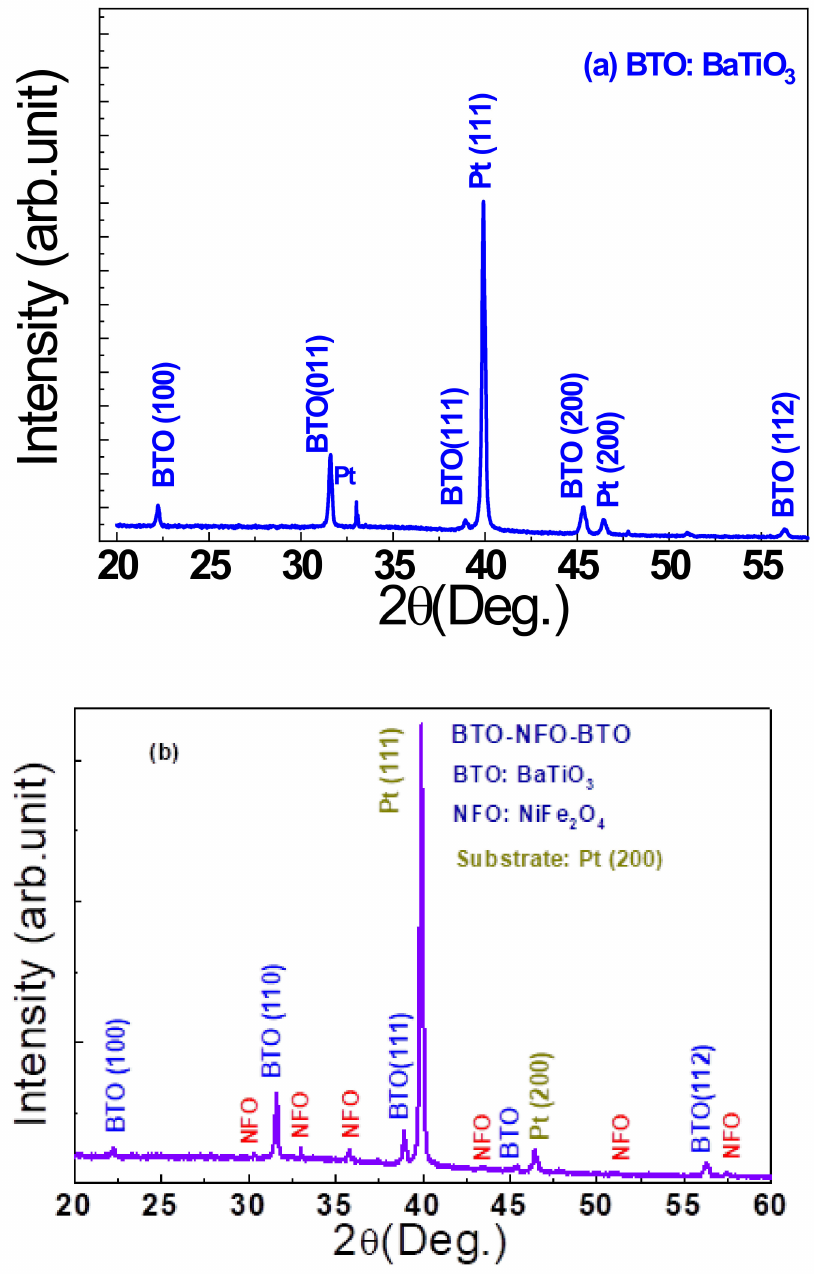
Figure 1. X-ray diffraction pattern of ( a ) BTO and ( b ) (BTO/NFO/BTO) tri-layered thin film on substrate Pt/Ti/SiO 2 /Si at room